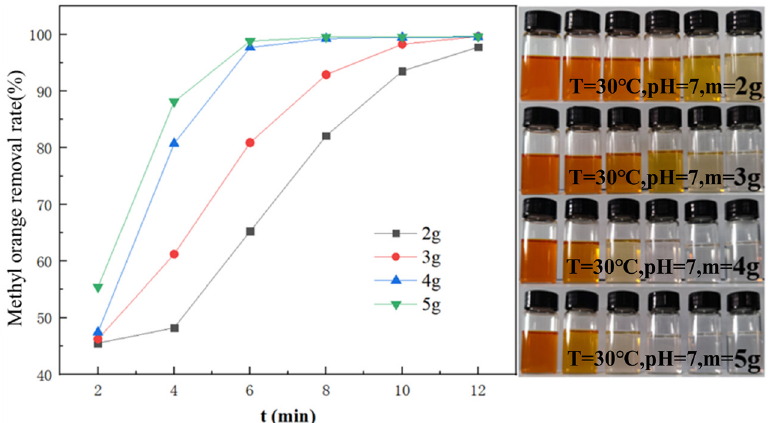
Figure 14. E ff ect of fi ller addition on methyl orange removal. Figure 14. Effect of filler addition on methyl orange removal.